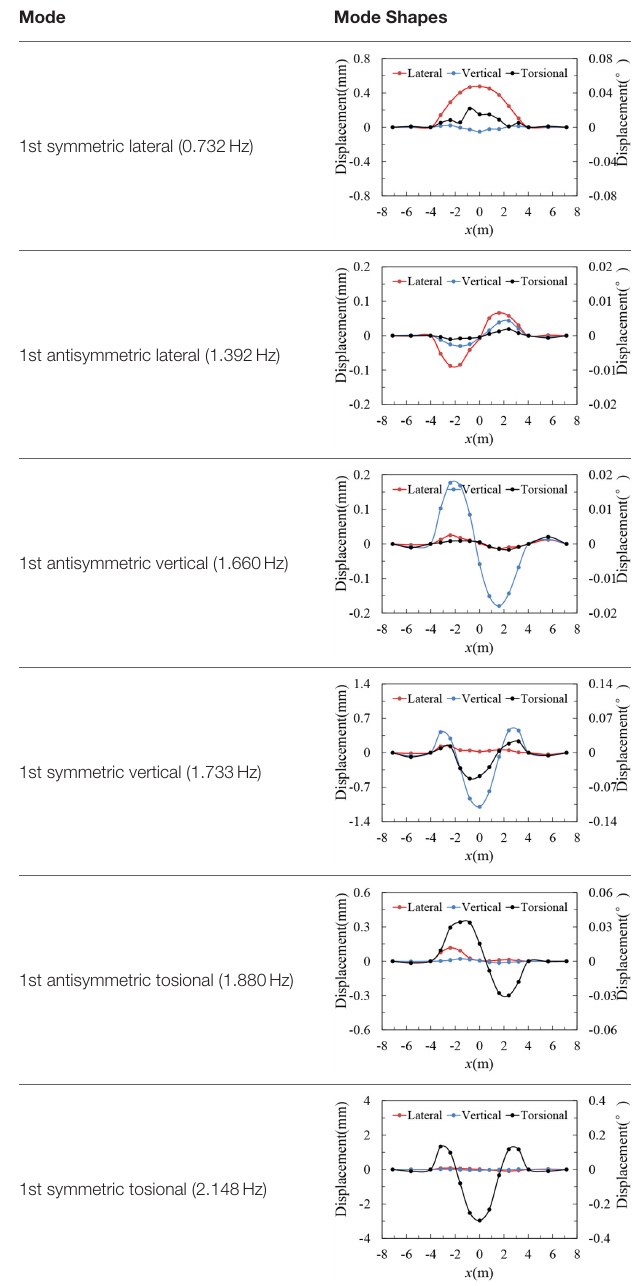
TABLE 4 | Free-vibration characteristic with central